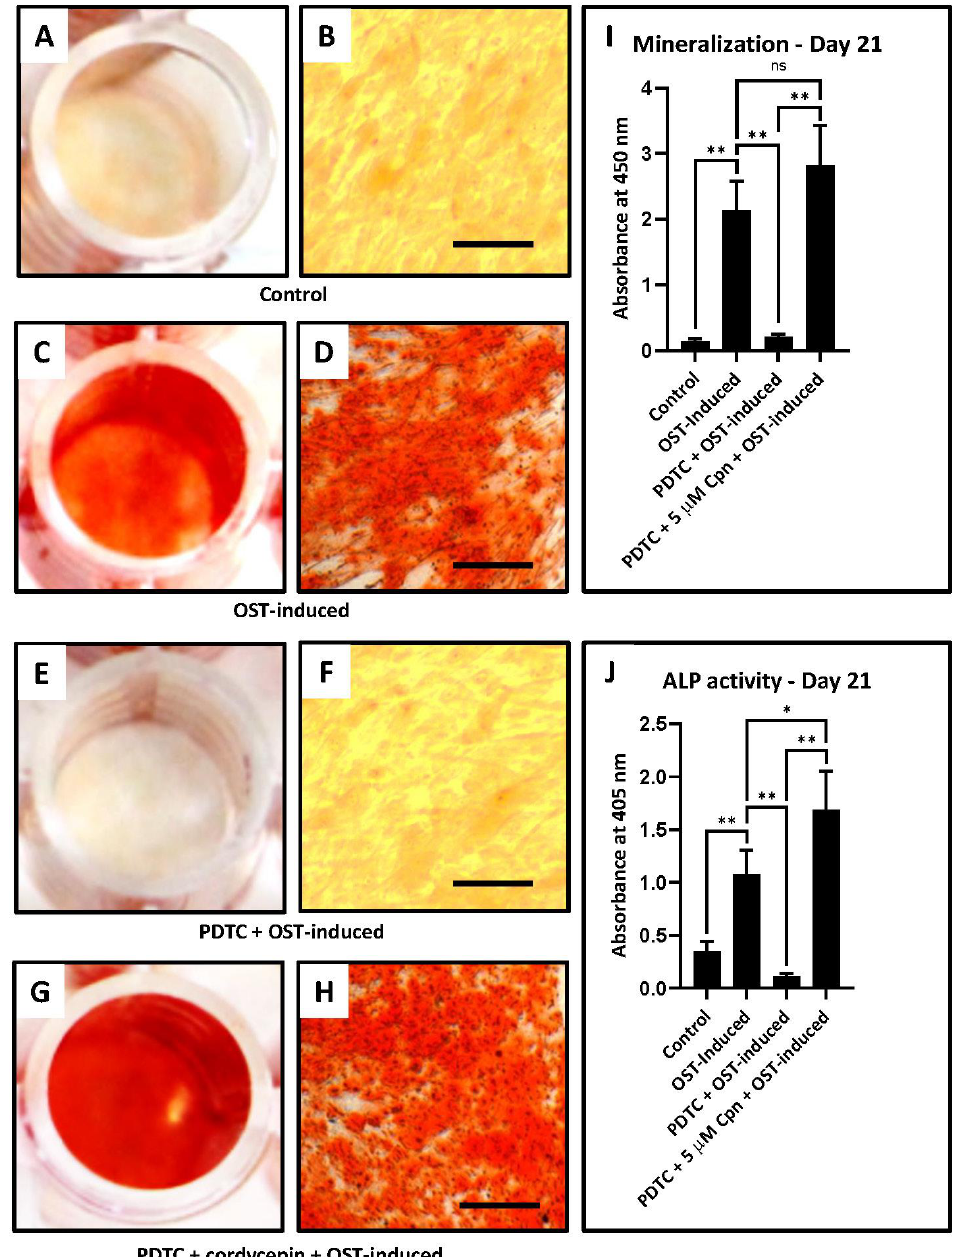
Figure 3. Osteogenic differentiation of DPSCs, quantification of mineralization, and alkaline phosphatase activity. ( A – H ) Osteogenic differentiation was induced in DPSCs with and without treatment with cordycepin and